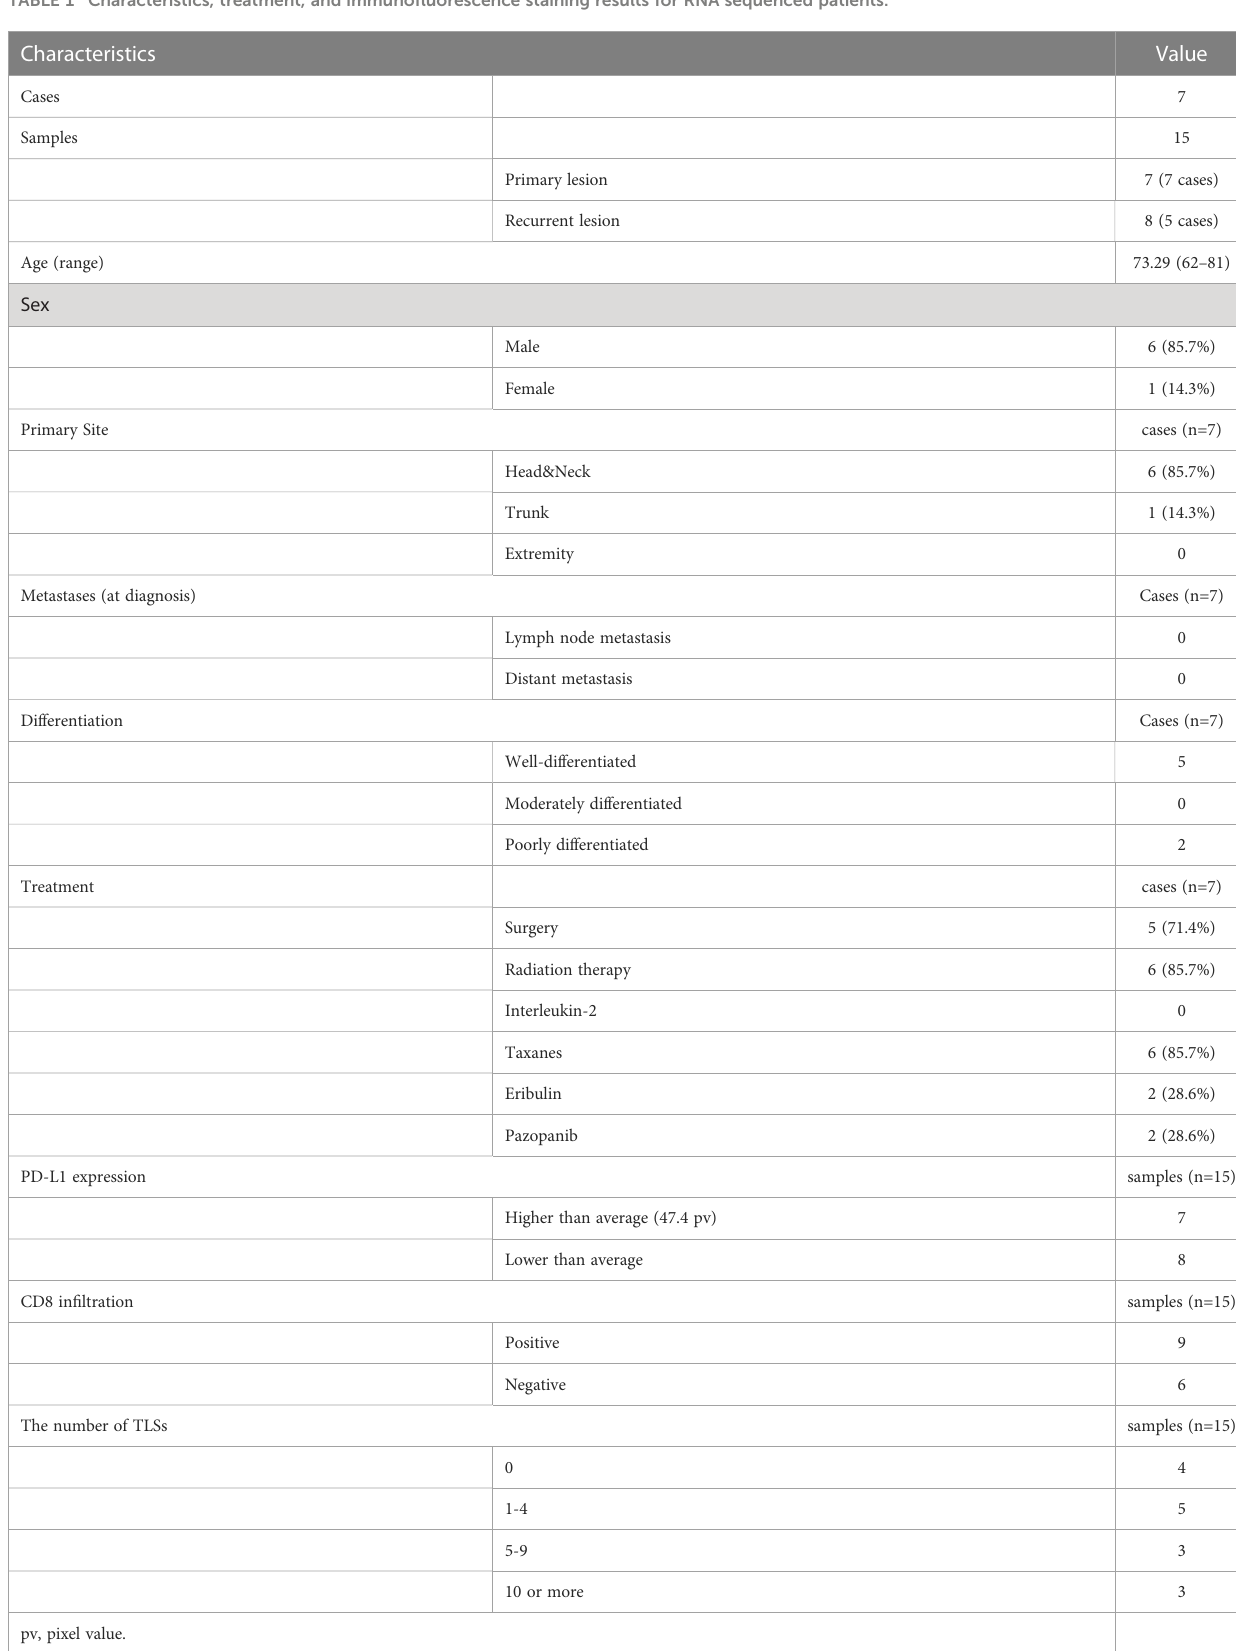
TABLE 1 Characteristics, treatment, and immuno fl uorescence staining results for RNA sequenced patients.